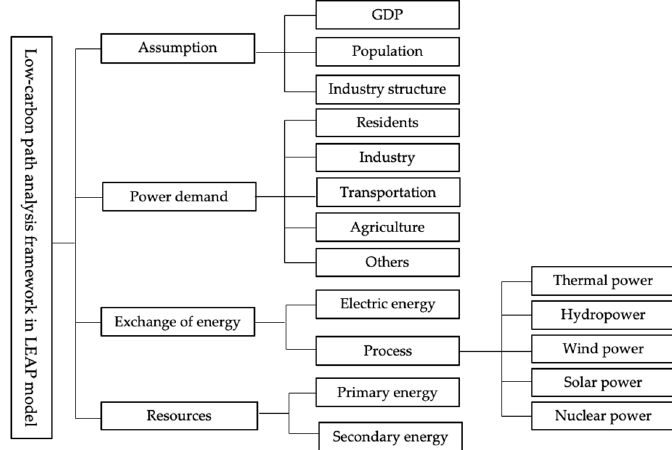
Figure 4. The principle of the LEAP model with modification.